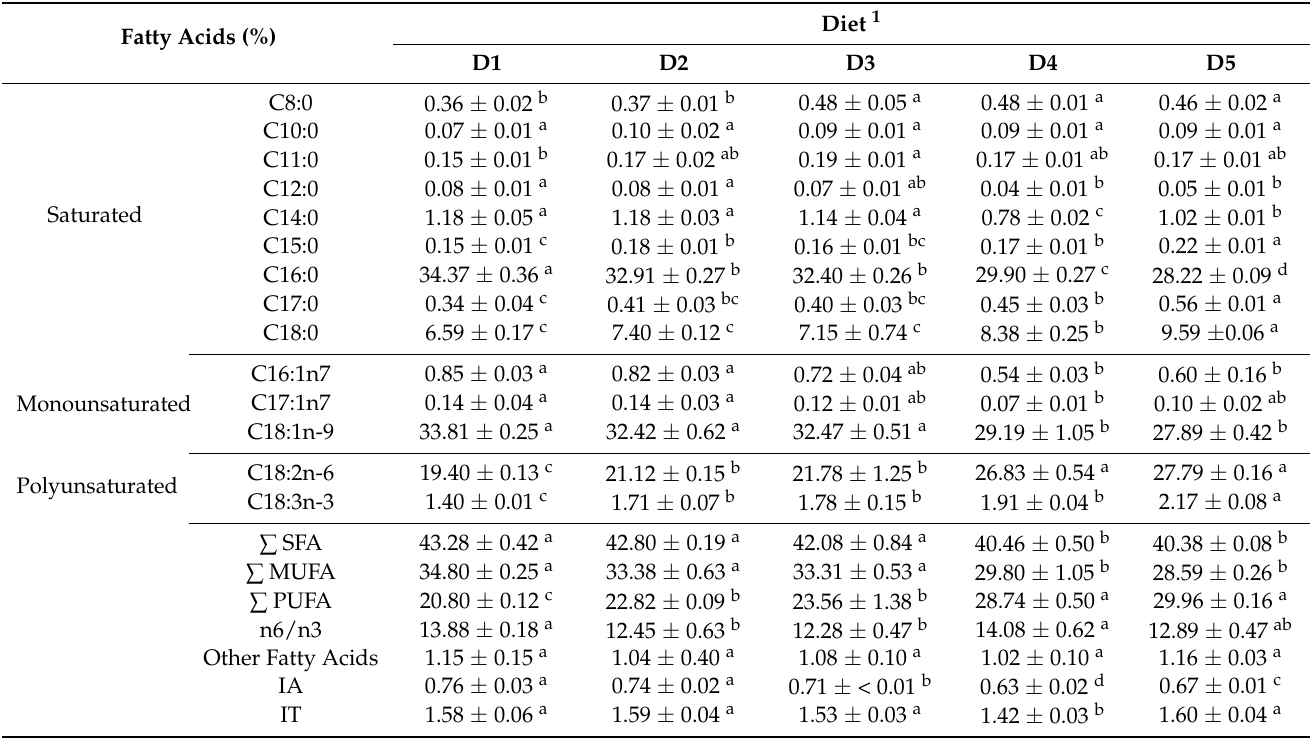
Table 4. Fatty acid profile of Zophobas atratus larvae fed with a conventional diet with and without grape residue (D1 to D5) for 90 days (dry